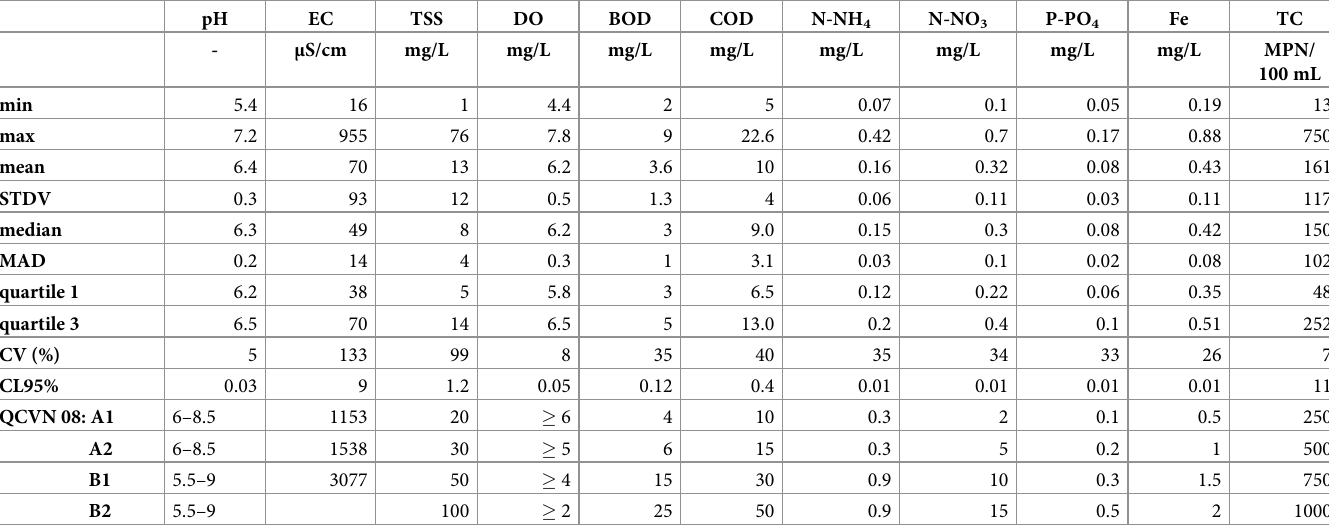
Table 1. Descriptive statistics for the 11 selected parameters (n = 396) ( � )